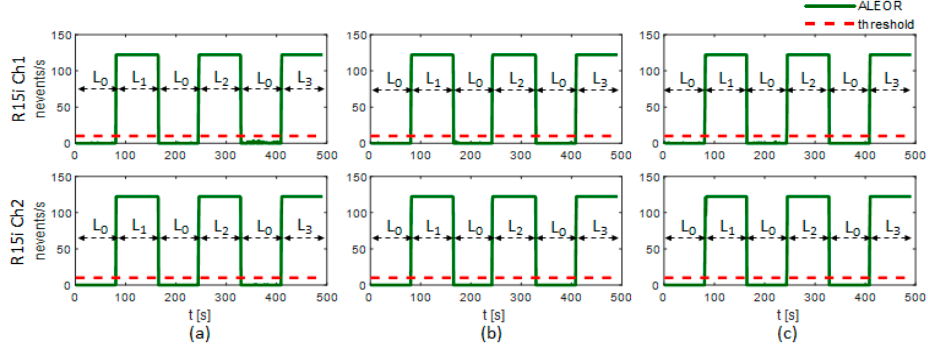
Figure 10. ALEOR under different pressure conditions: ( a ) P 0 , ( b ) P 1 , ( c ) P 2.